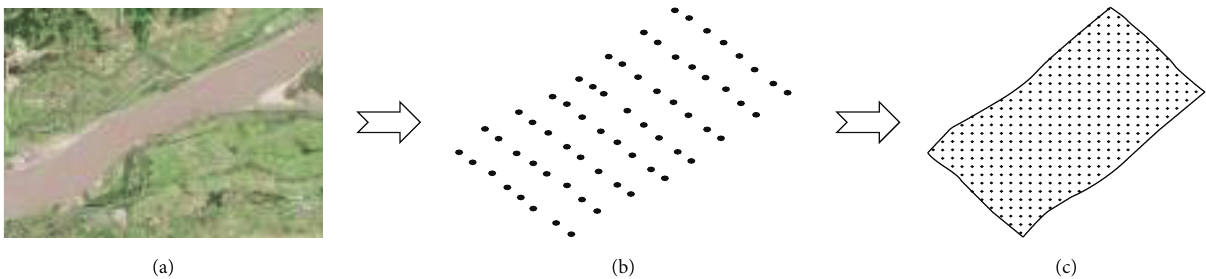
Figure 3: The processes of depth measurement and DEM building of the river channel. (a) River course; (b) cross section measurement (dots are bathymetric points); (c) grid DEM